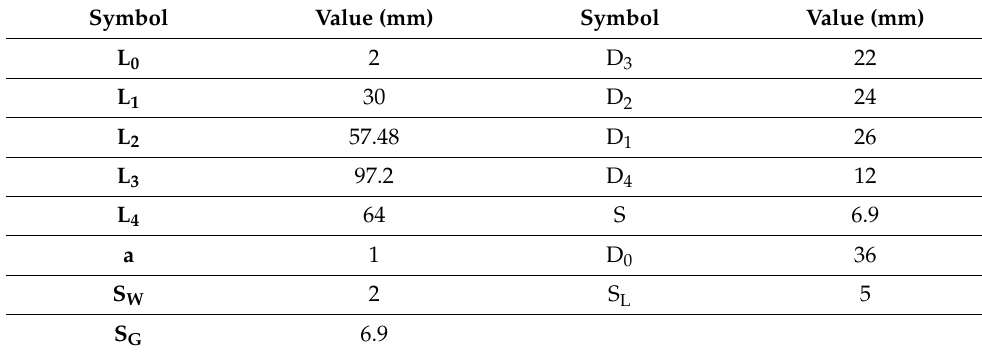
Table 1. Dimension parameters of the proposed